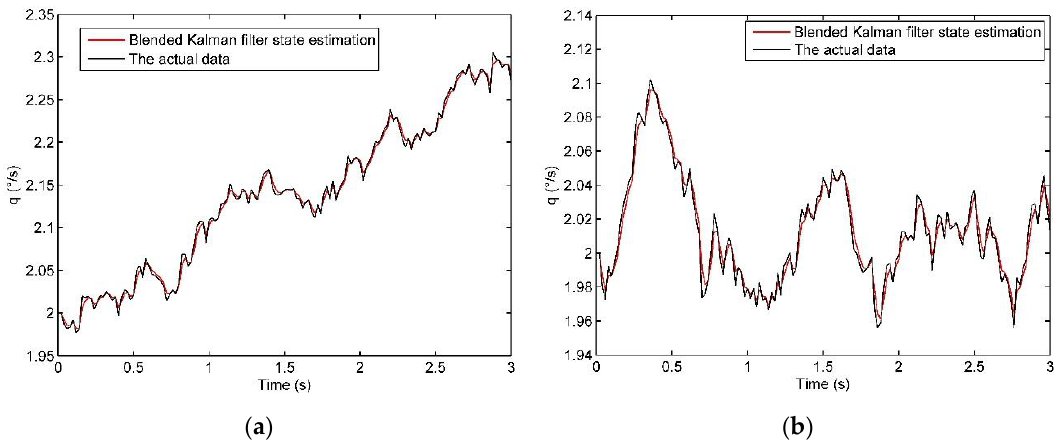
Figure 9. Type C fault vs. fault-free state estimation: ( a ) type C fault state estimation; ( b ) type C fault-free state estimation.